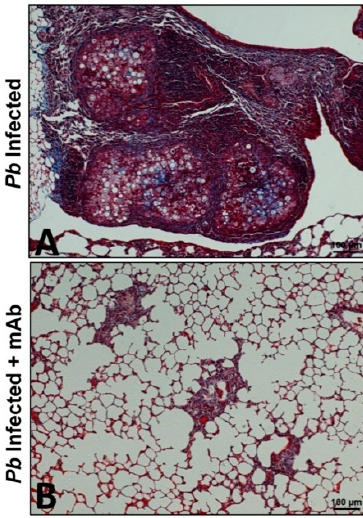
Figure 1. A monoclonal antibody against neutrophils-reduced pulmonary fibrosis in the lungs of mice infected with P. brasiliensis . Microphotographs are representative of lungs from infected and untreated mice ( A ) or infected and treated with a monoclonal antibody (anti-Ly6G) specific to neutrophils ( B ) at 12 weeks post-challenge. The lungs were fixed, embedded in paraffin, cut, and stained using Masson’s trichrome to identify and differentiate collagen fibers. Magnification 10X.